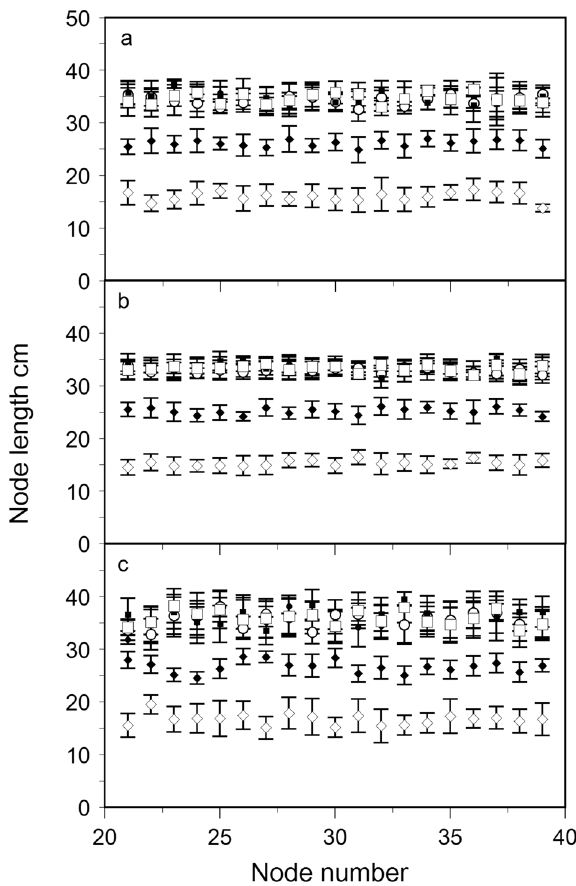
Figure 4. The kinetics of bine elongation from node 20–40 + /- standard deviation for ( a ), cultivar ‘Cascade’, ( b ), cultivar ‘Centennial’ and ( c ), cultivar ‘Cashmere’ control free to climb at 90° (FC; of 90° netting (FN; ○ ), free to climb twine at 45° (F45; ■ ), touch on twine at 45° (T45; □ ), touch on a strand of trellis netting at 45° slope (N45; ◆), and 90° internode bending on netting at a 45° mean slope (B90; ◇ ). Vertical bars represent standard deviations of six replicates (n = 6). Internode lengths among treatments are statistically different from each other ( P <